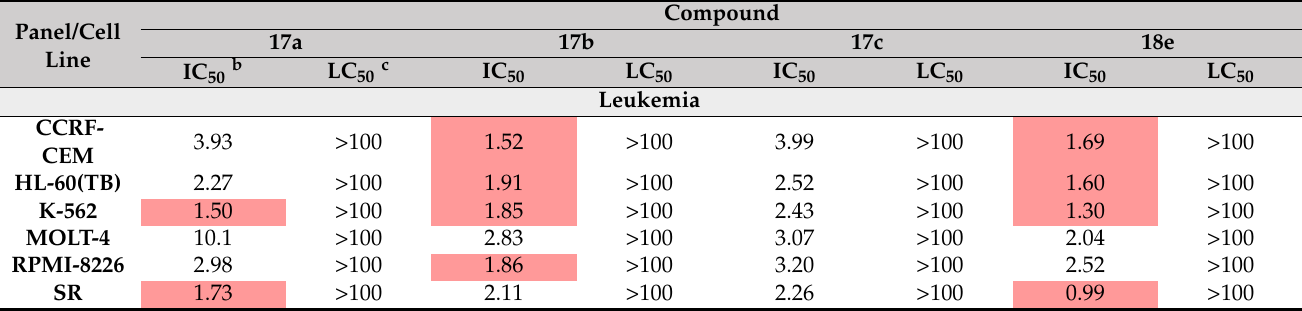
Table 1. In vitro cytotoxic activity recorded for hybrids 17a-c and 18e against the panel of 60 cancer cell lines in five-dose screen, expressed as IC 50 and LC 50 in micromolar ( µ M) a